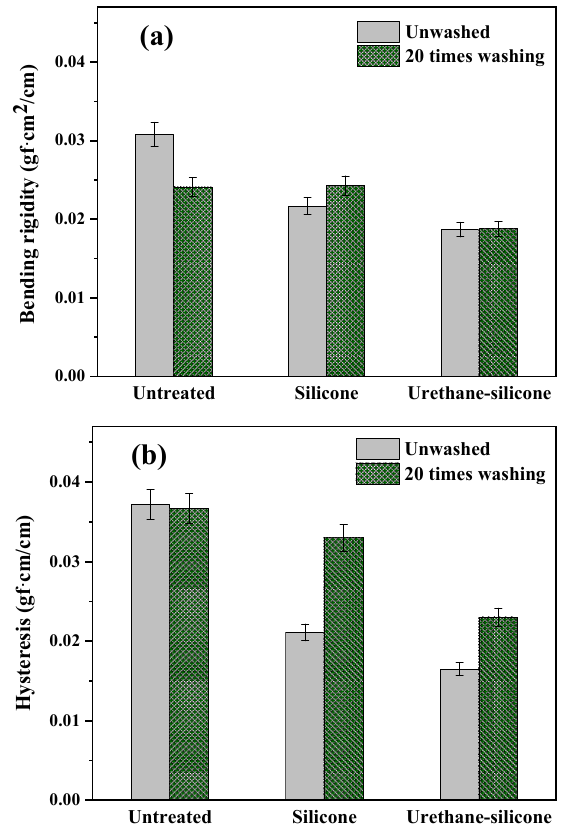
Figure 10. Bending properties of the cotton knit fabric untreated and treated with softeners. ( a ) Bending rigidity; ( b ) hysteresis.